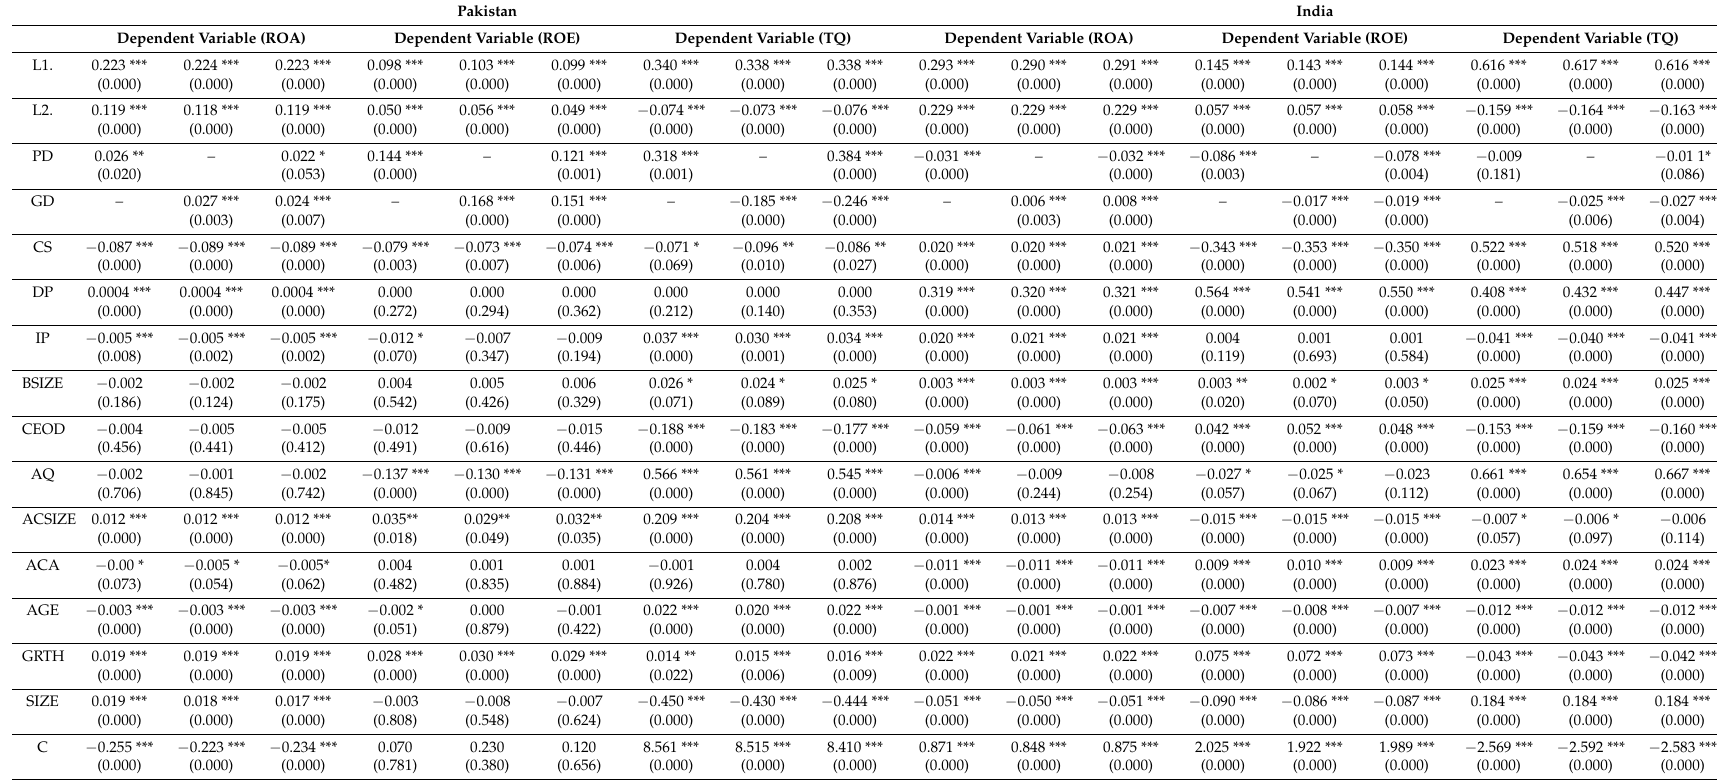
Table 6. Two-step System Dynamic Panel Regression (Pakistan and India). Pakistan